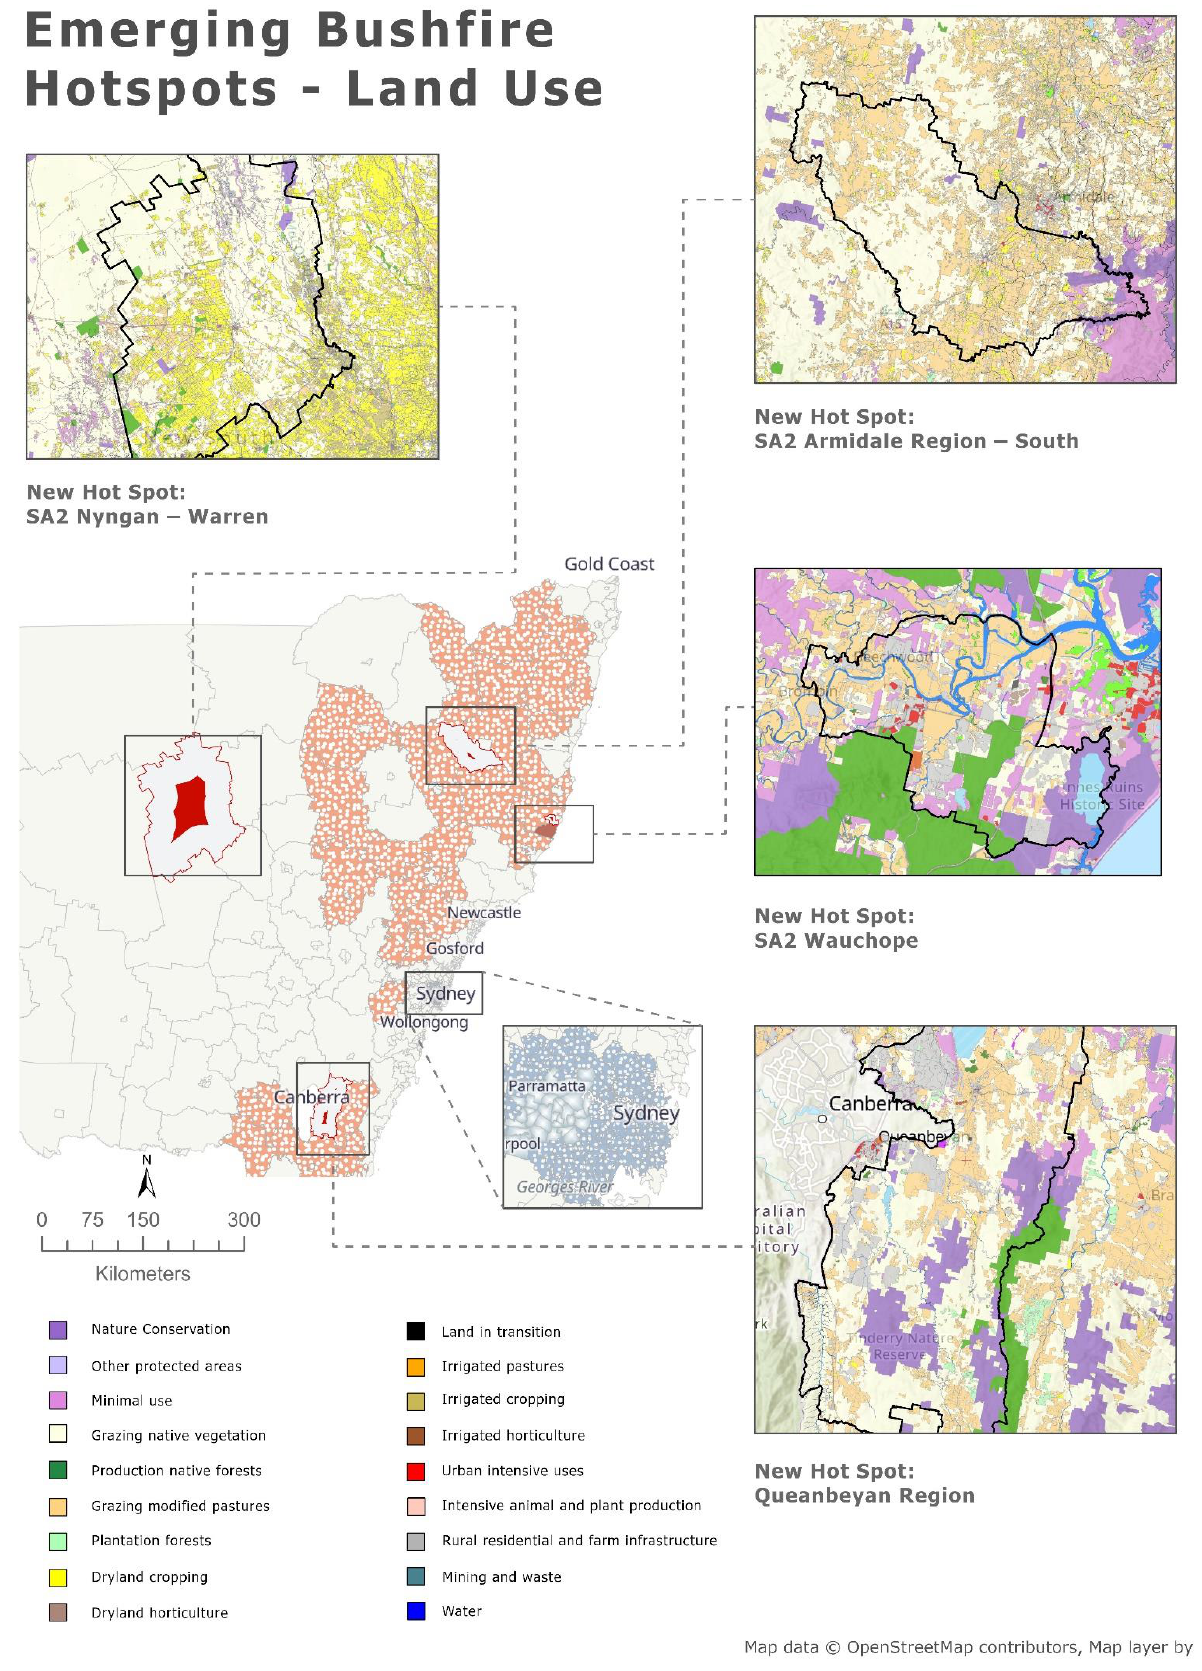
Figure 16. Land-use types for the hotspots of